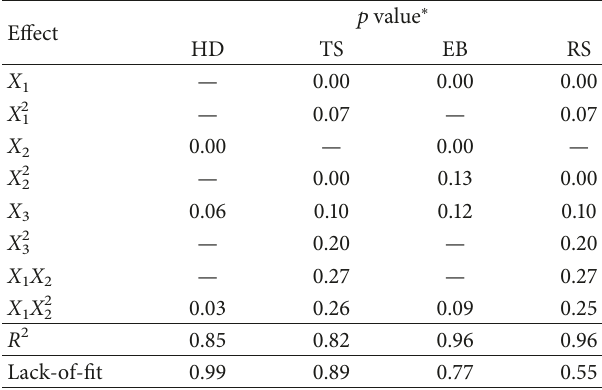
∗ Value could not be measured. Table 5: Major statistical properties [7, 8] relevant for variance analysis ( R 2 , p value for the significance and lack-of-fit tests) of the calculated regression models ( X 1 calcium carbonate, X 2 paraffinic oil, and X 3 vulcanising